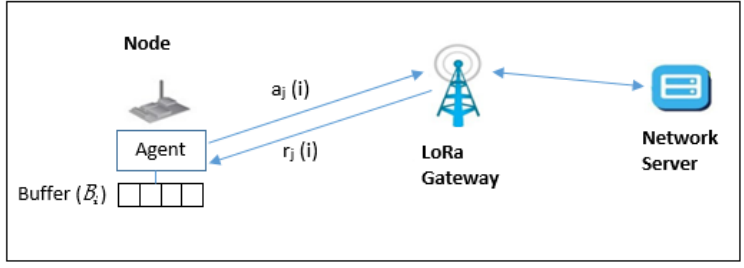
Figure 2. The modified LoRa